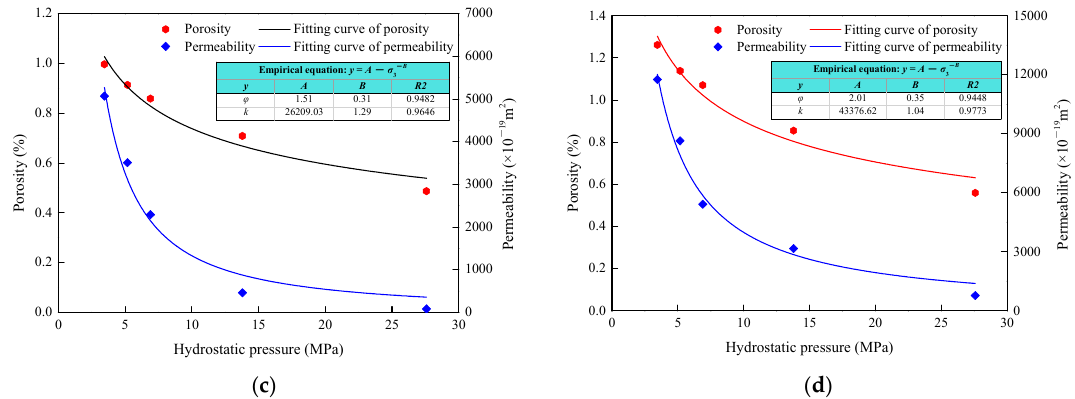
Figure 10. Permeability and porosity versus hydrostatic pressure. ( a ) ω = 3.00% (SR-1); ( b ) ω = 13.07% (SR-2); ( c ) ω = 39.16% (SR-3); ( d ) ω = 60.02% (SR-4).